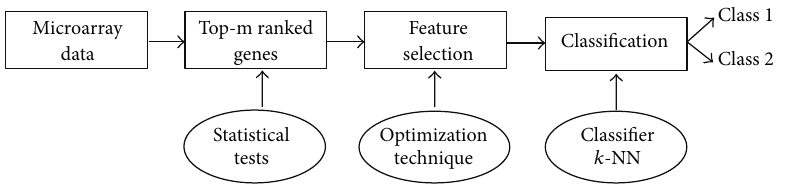
Figure 1: Schematic representation of the proposed